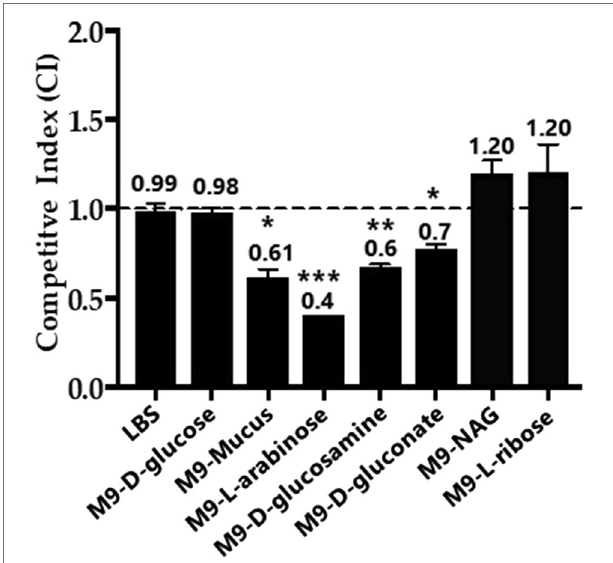
FIGURE 7 | In vitro growth competition assay between wild type and the Δ fis mutant. WBWlacZ and Δ fis were grown in co-culture (1:1 ratio) for 24 h in LBS, M9 supplemented with 100 μ g/ml intestinal mucus, 10 mm of D-glucose, L-arabinose, D-glucosamine, D-gluconate, N-acetyl-D-glucosamine (NAG), or D-ribose. WBWlacZ outcompetes Δ fis , <1.00, and Δ fis outcompetes WBWlacZ when >1.00. The assay was conducted in two biological replicates in triplicates. Error bar indicates SEM. Unpaired Student’s t -test was conducted. The significant difference is denoted by asterisks (* p < 0.05, ** p < 0.01, *** p <